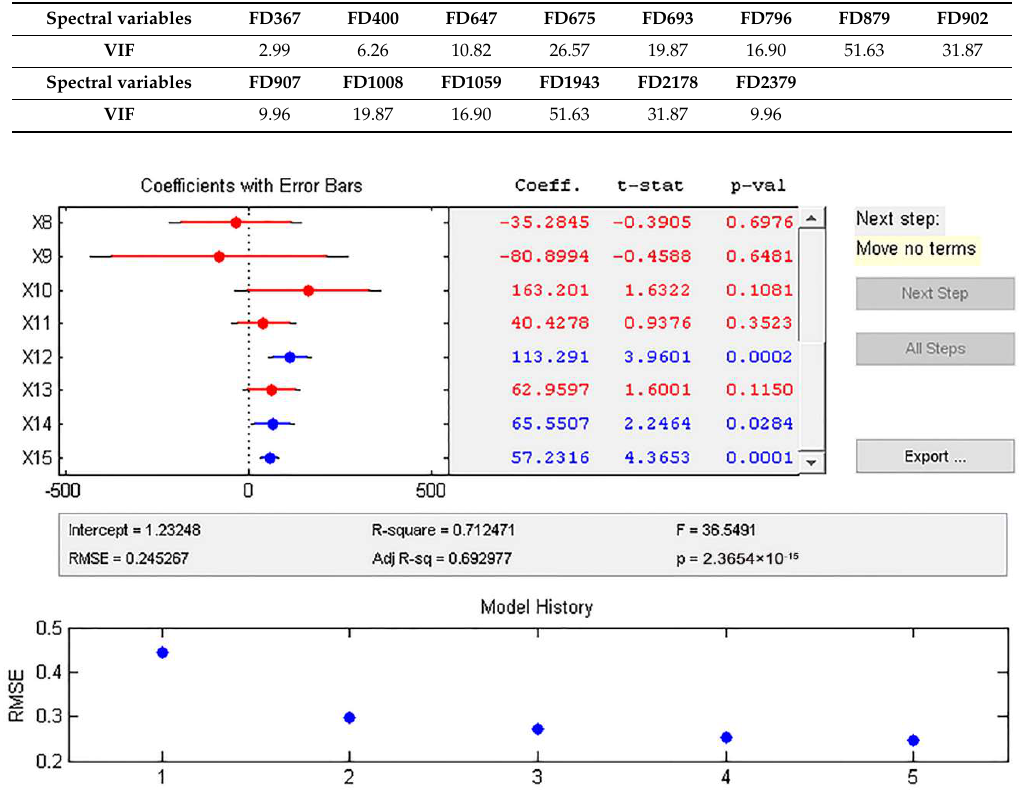
Figure 14. The selection procedure of the optimal relevant spectral variables FD 1059 , FD 2178 , and FD 2379 , represented using X 12 , X 14 , and X 15 , respectively, for developing the estimation model of soil heavy metal Cd content.